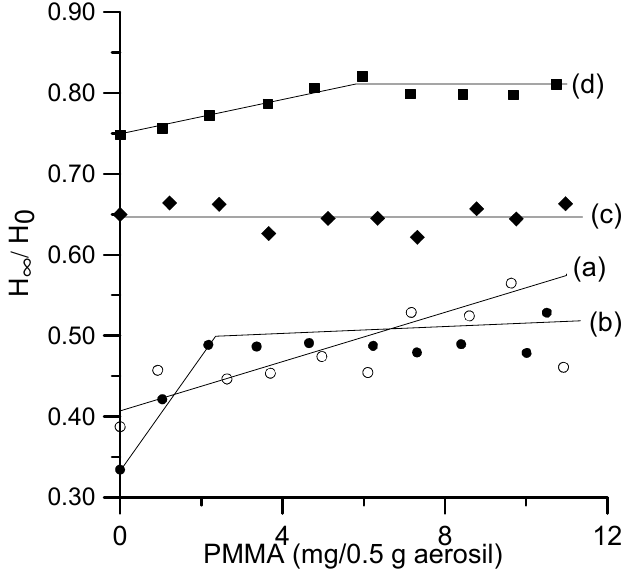
Figure 8. Representation of the relative sediment height H concentration (mg/0.5 g aerosil) in the absence ( a ) and in the presence of the monomer additive ethyleneglycoldimethacrylate ( b ), polyethyleneglycoldimethacrylate of molecular weight equal to 330 ( c ) and 875 ( d ),